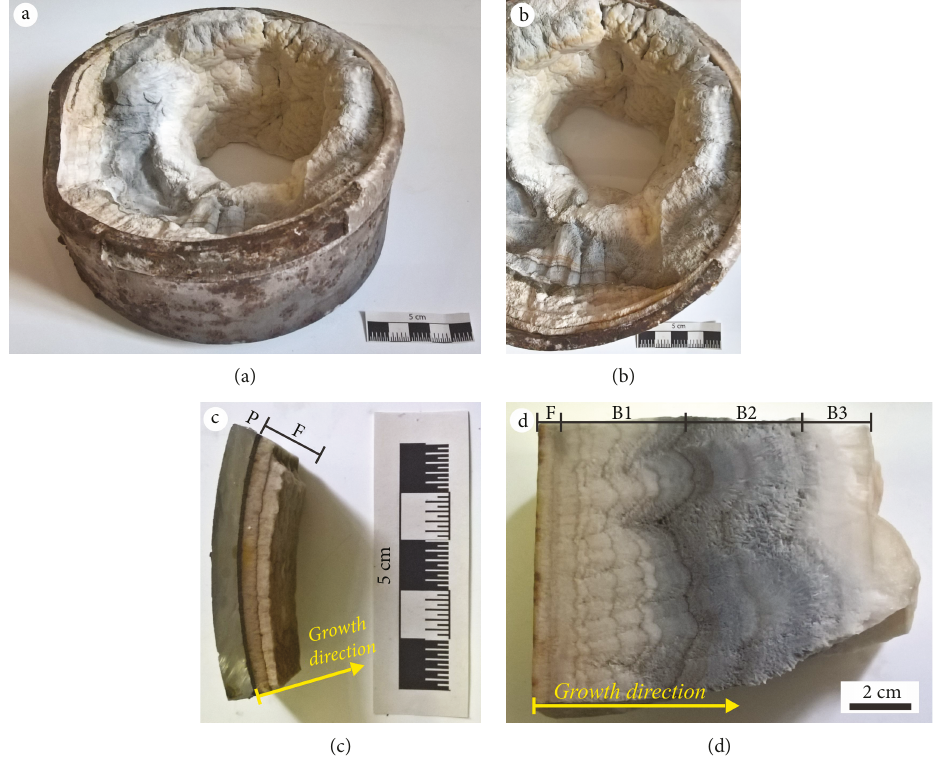
Figure 9: Thick carbonate scale samples from the Újszeged geothermal cascade system sampled from a pipe between the production well and the bu ff er tank. (a, b) Macroscopic images of the sample G-03 (total length of the scale bar: 5cm). (c) Outer part of the sample G-03, showing a fi brous (F) morphology. Substrate material (pipe, P): carbon steel. (d) Inner part of the sample G-03, showing a complex morphology with fi brous (F) to botryoidal (B1 to B3) zones. Note: B1/B2 boundary (an intermittent brownish stained layer) separates seasonal (annual) operational rhythms. Fine lamination represents e ff ects related to the periodical (weekly or daily) operational